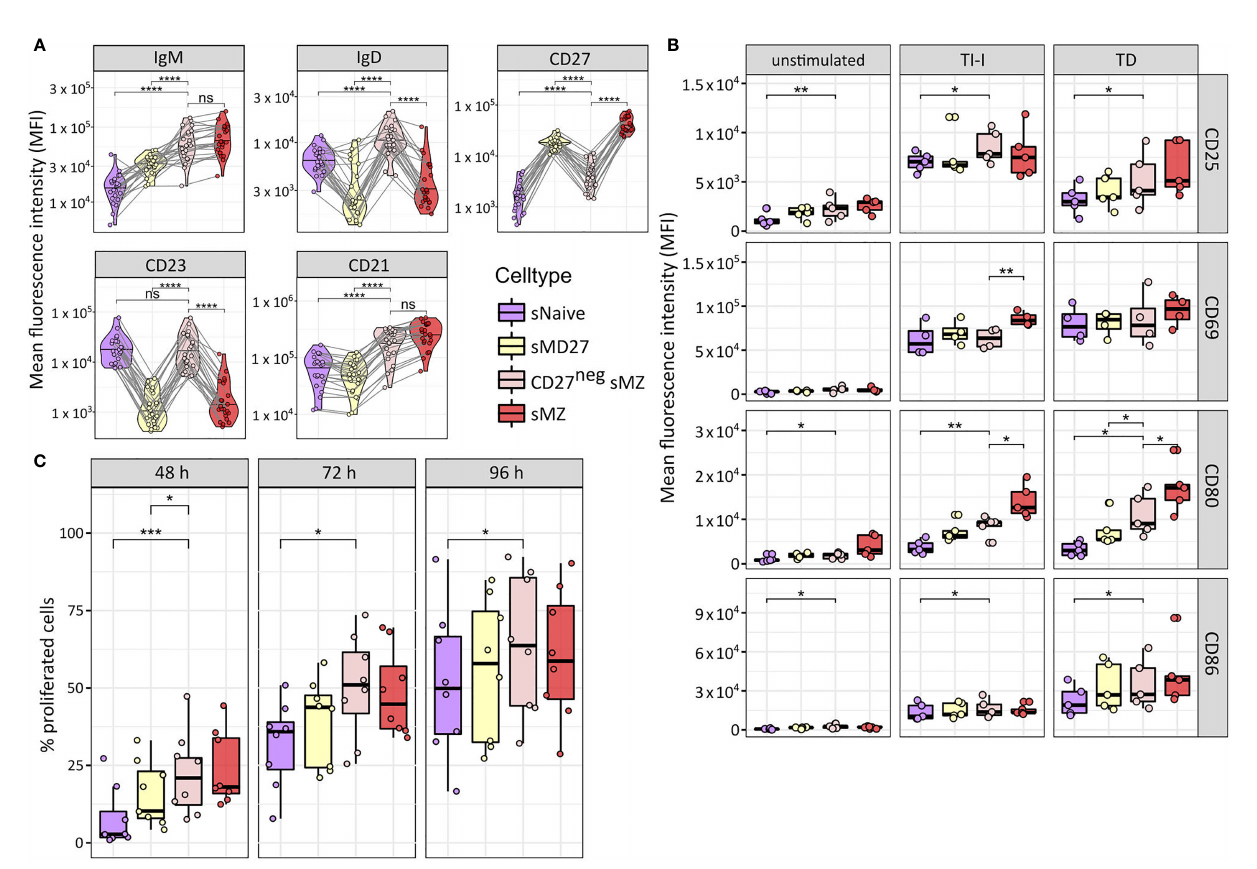
FIGURE 3 | Phenotypic and functional characterization of splenic CD27 neg CD21 high IgM high B cells. (A) Surface expression of IgM, IgD, CD21, CD23, and CD27 among splenic naïve, IgM memory, CD27 neg CD21 high IgM high , and sMZ B cells as determined by fl ow cytometry using the gating strategy as in Figures 1A , 2A . B-cell subsets from the same donor are connected with lines. (B) Surface expression of CD25, CD69, CD80, and CD86 among resting B-cell subsets or upon 24 h of in vitro stimulation (TI-I and TD). Color code as in panel (A, C) Fraction of proliferated cells (eFluor670 low ) upon 48, 72, or 96 h of in vitro culture with TD and TI-I stimulation. Color code as in panel (A) Statistical signi fi cance was calculated by Wilcoxon rank-sum test using paired samples (*p ≤ 0.05; **p ≤ 0.005; ***p ≤ 0.001; ****p ≤ 0.0001; ns, p >